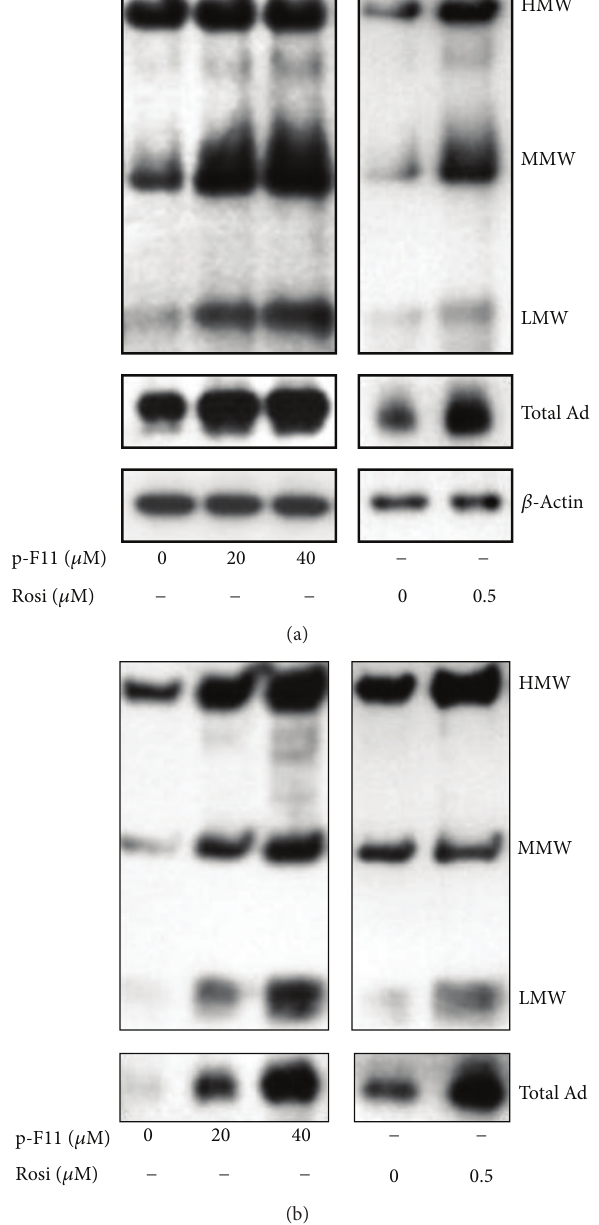
Figure 2: p-F11 promotes adiponectin oligomerization and secre- tion in 3T3-L1 adipocytes. 3T3-L1 adipocytes were treated with p- F11 or Rosi for 24 hours. The amount of each oligomer and total adiponectin in the cell lysates (a) or in the culture medium (b) were detected as described in Figure 1(d).